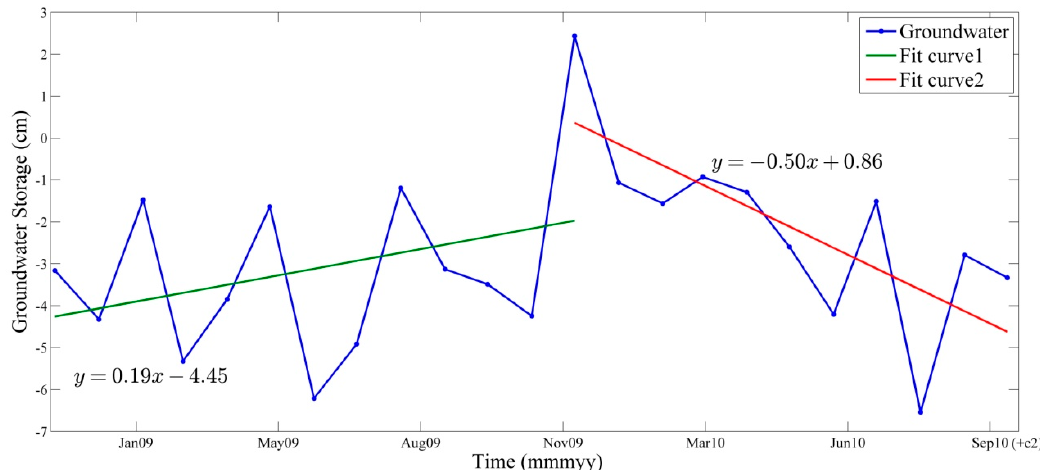
Figure 9. Variation in groundwater storage from December 2008 to October 2010.